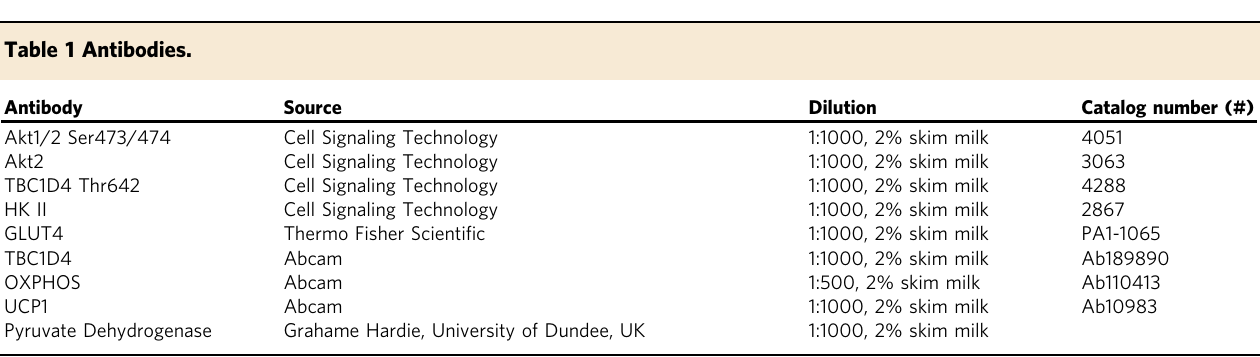
Fig. 6 Thermoneutral housing supersedes the effect of exercise on gut microbiome composition. a Housing mice at 30 °C markedly alters gut microbiome composition with minor effect of exercise training (ET). Upper panel: dbRDA on Bray-Curtis distance of cecal 16S rRNA gene (V3-region) amplicons (zOTU level) and adjusted for the time effect of the paired-treatments (See Supplementary Fig. 5c for unconstrained Bray-Curtis PCoA plot). Lower panel: dbRDA plot of cecal (similar as above) clustering GM samples by housing temperature. The groups are separated by the colors indicated in the fi gure. ANOSIM test determined signi fi cant differences between experimental groups with mice housed at 22 °C, 30 °C, and paired 22 °C [ R > 0.13, p < 0.04], were observed. 22 °C untrained (UT); n = 8, 22 °C ET; n = 10, 30 °C UT; n = 9, 30 °C ET; n = 10, paired 22 °C UT; n = 10, paired 22 °C ET; n = 10. b – e Volcano plots showing the change of speci fi c phylotypes (zOTUs) within the different experimental groups; untrained mice at 22 °C and 30 °C ( b ), ET at 22 °C ( c ), ET at 30 °C, and ET at paired 22 °C; t- test, FDR p ≤ 0.05 indicated. 22 °C UT; n = 8, 22 °C ET; n = 10, 30 °C UT; n = 9, 30 °C ET; n = 10, paired 22 °C UT; n = 10, paired 22 °C ET; n = 10. f The relative abundance of species summarized to the family level as indicated. 22 °C UT; n = 8, 22 °C ET; n = 10, 30 °C UT; n = 9, 30 °C ET; n = 10, paired 22 °C UT; n = 10, paired 22 °C ET; n = 10. g – i The relative abundance of bacteroidetes ( g ) and Firmicutes ( h ), and the ratio ( i ) between these two phyla. Statistical testing; Two-way ANOVA. 22 °C UT; n = 8, 22 °C ET; n = 10, 30 °C UT; n = 9, 30 °C ET; n = 10, paired 22 °C UT; n = 10, paired 22 °C ET; n = 10. The “ n = x ” de fi nes the number of biologically independent animals used for the analyses.